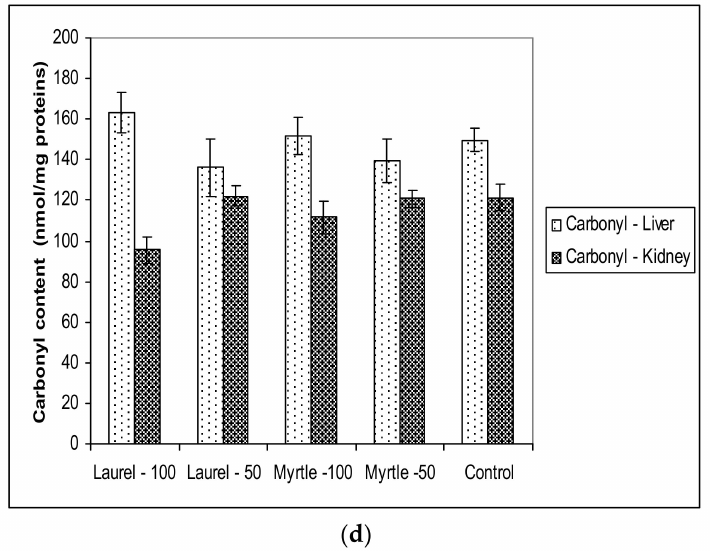
Figure 5. The effect of Laurel and Myrtle extract on oxidative stress biomarkers in the liver and kidney tissues homogenates measured by MDA level ( a ), GSH level ( b ) CAT activity ( c ) and carbonyl content ( d ). Male rats ( n = 5) were administered Laurel and Myrtle extracts ig at a dose of 50 and 100 mg/kg once a day for 14 days. The control group was treated with ig saline. The results are expressed as the mean value of each experimental group ± SE of the mean of two different (cid:4) observations. * Significantly different in relation to Control (* p < 0.05). Significantly different (cid:4)(cid:4) p (cid:7) (cid:7) p in relation to Myrtle-100 ( < 0.01); Significantly different in relation to Laurel-100 ( < 0.05) (cid:3) (cid:3) p ♦ Significantly different in relation to Myrtle-50 ( < 0.05); Significantly different in relation to ♦ p Laurel-50 ( <